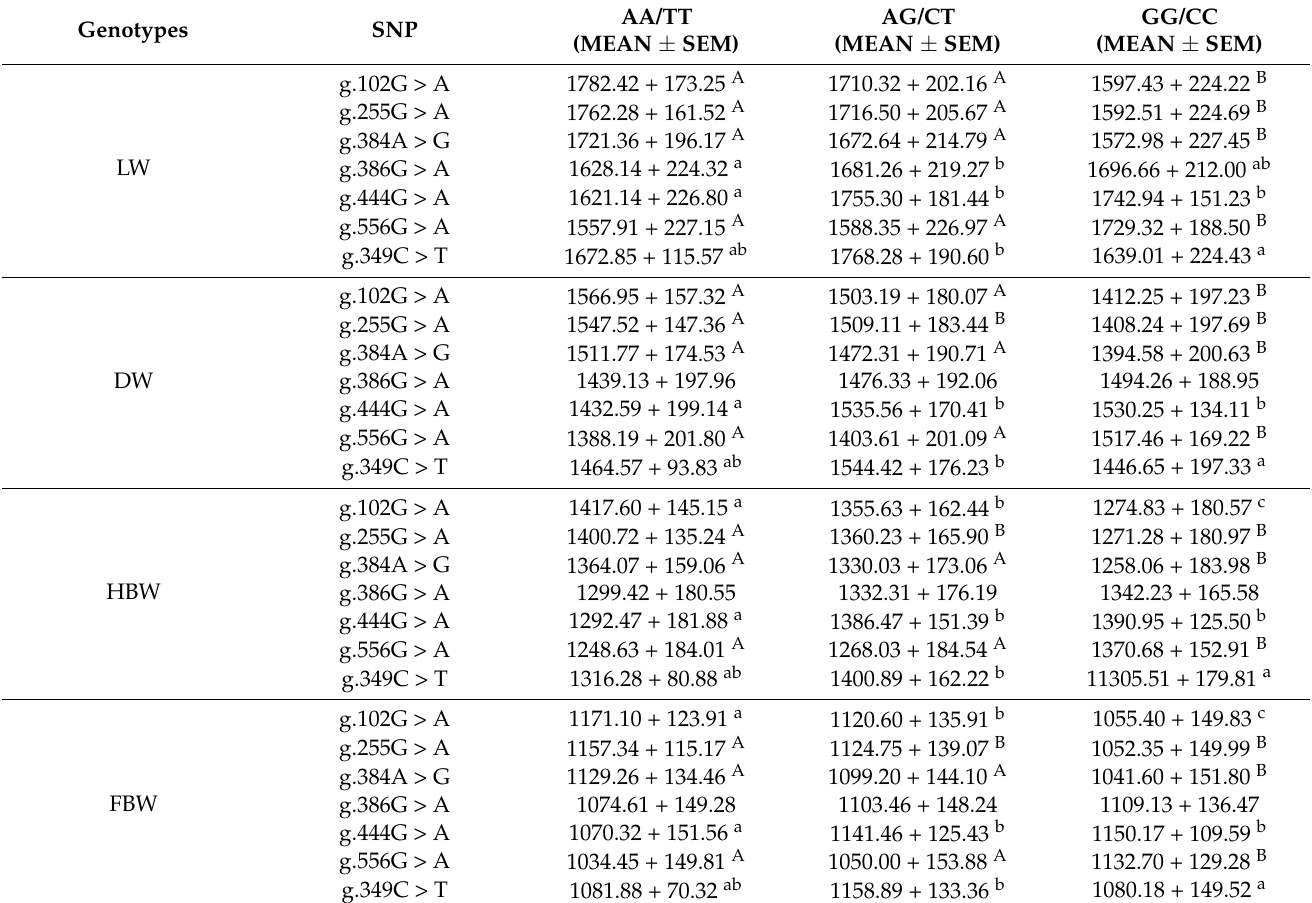
Table 4. Association analysis of G0S2 SNPs with carcass traits (MEAN ±